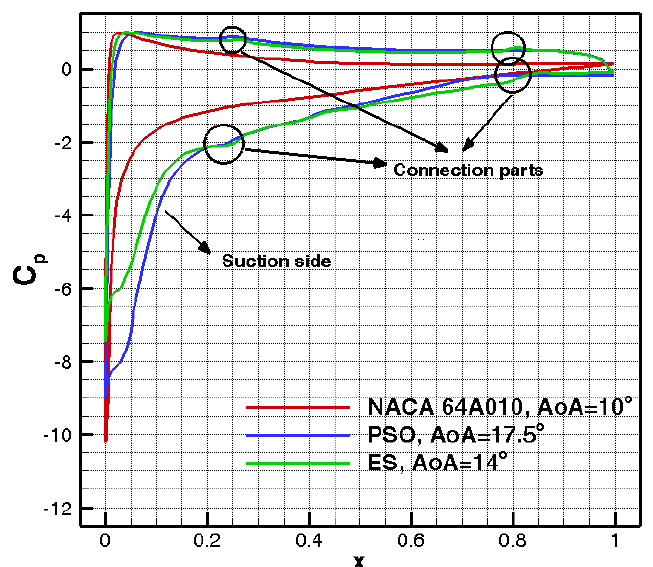
Figure 12. Pressure coefficient distribution for the airfoils produced by the PSO and ES optimization algorithms at the maximum C L angles of attack. Flow field was simulated using Foil2w.